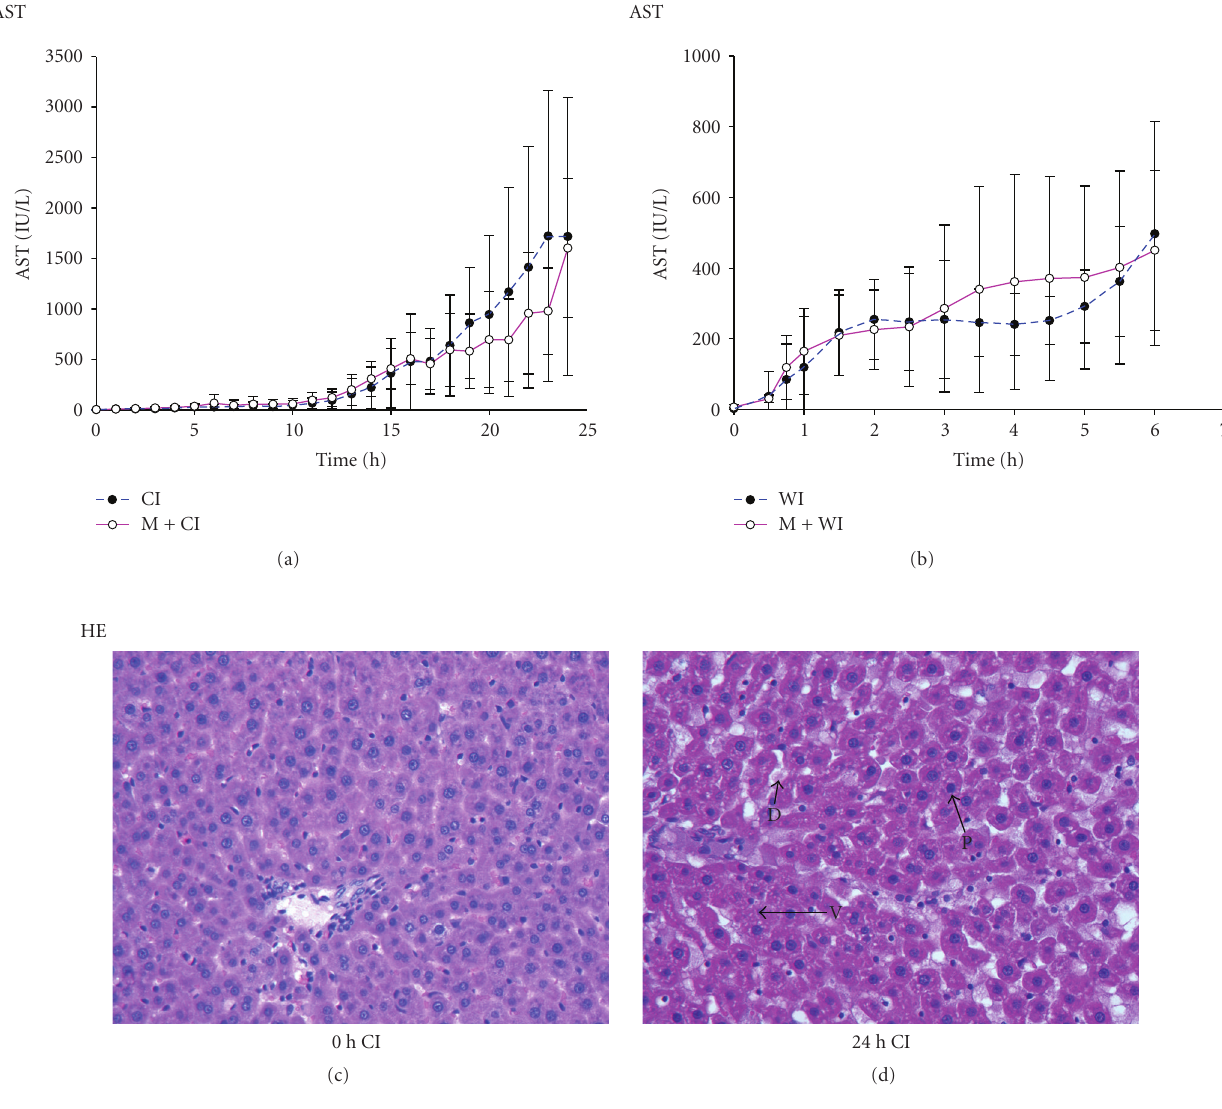
Figure 2: Liver damage during ischemic storage. Liver enzymes in the e ffl uent increased gradually in parallel to the length of warm/cold ischemia time. Mean total liver enzymes values were higher, but not significantly ( P > . 05) ((a) and (b)). Liver injury was confirmed by liver histology (original magnification, 200x). Progressive changes in hepatocyte morphology such as cell dissociation (D), cytoplasmic vacuolization (V), and nuclear pycnosis (P) did increase over ischemia time. (c) 0h cold ischemia (CI) liver tissue; (d) 24h CI liver